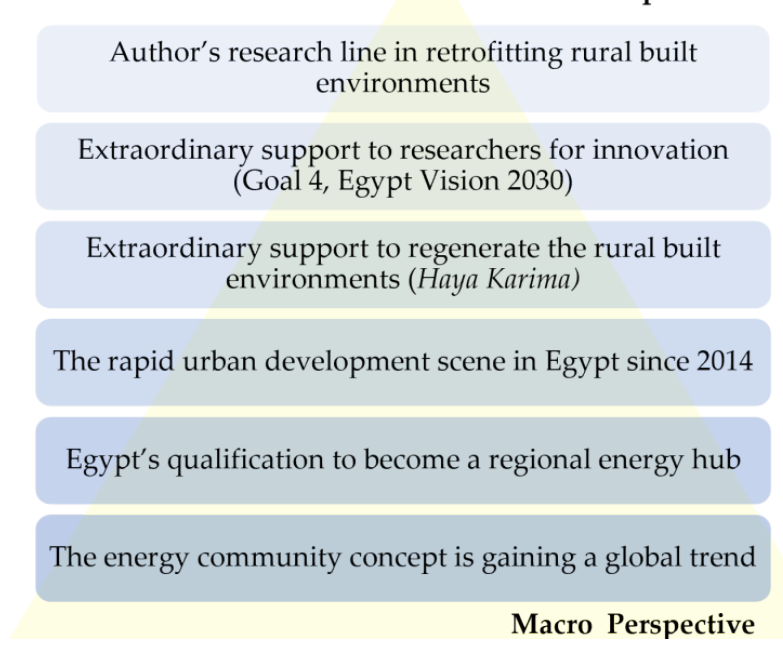
Figure 1. The argument’s rational background, from a global to national scale.